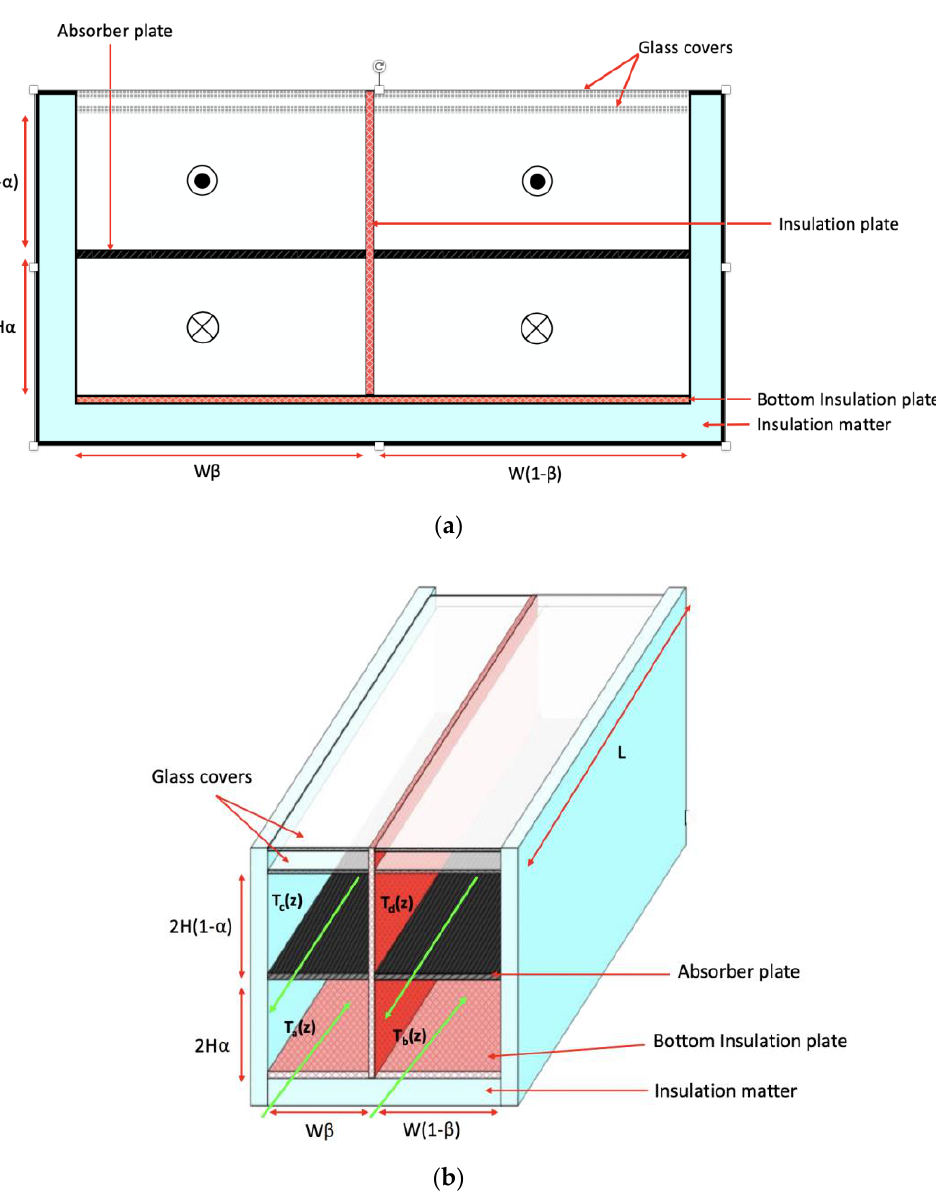
Figure 1. Schematic diagrams of a recycling multi-pass solar air collector: ( a ) Front view ( Flow out and Flow in); ( b ) Side view.